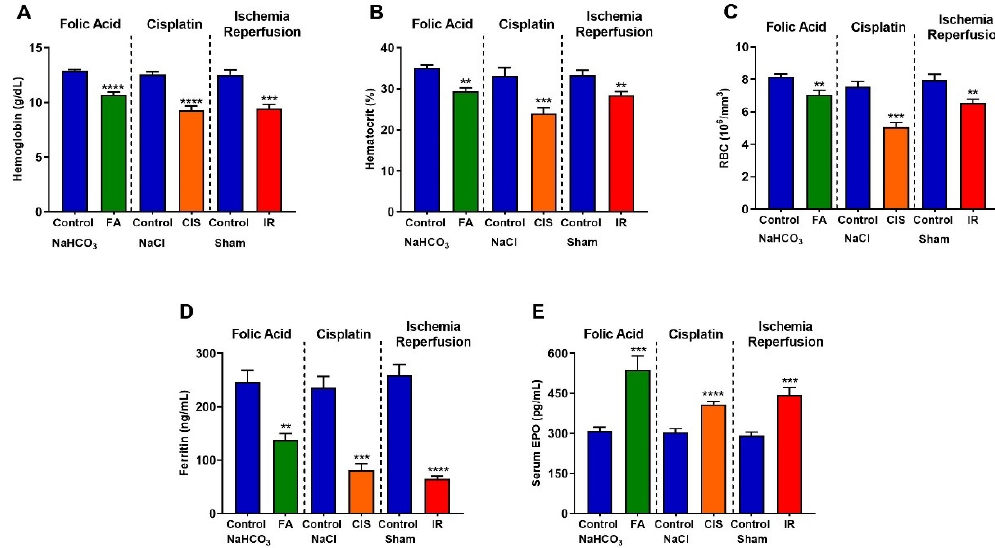
Figure 5. Chronic kidney disease leads to anemia. Hemoglobin ( A ), hematocrit ( B ), red blood cells ( C ), serum ferritin ( D ), and serum EPO (E) levels after folic acid (FA) treatment, cisplatin (CIS) treatment, and ischemia reperfusion (IR) surgery. Data presented as mean ± SEM; n = 6–8. Two-tailed Student´s t-test. ** p < 0.01; *** p < 0.001; **** p < 0.0001.